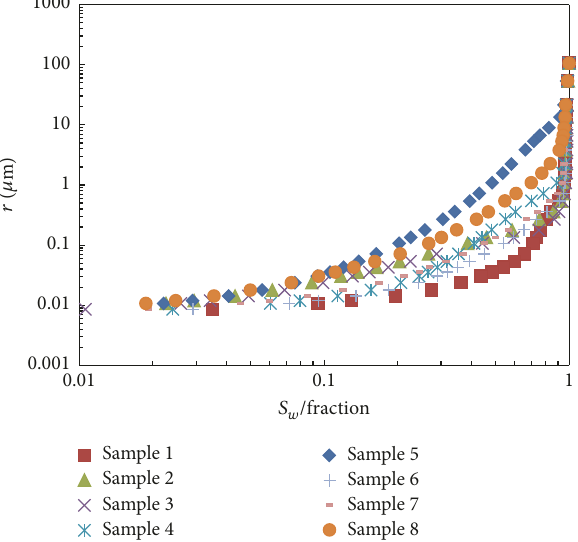
Figure 4: Relationship between the pore radius and wetting phase saturation transformed on the basis of a capillary pressure curve.